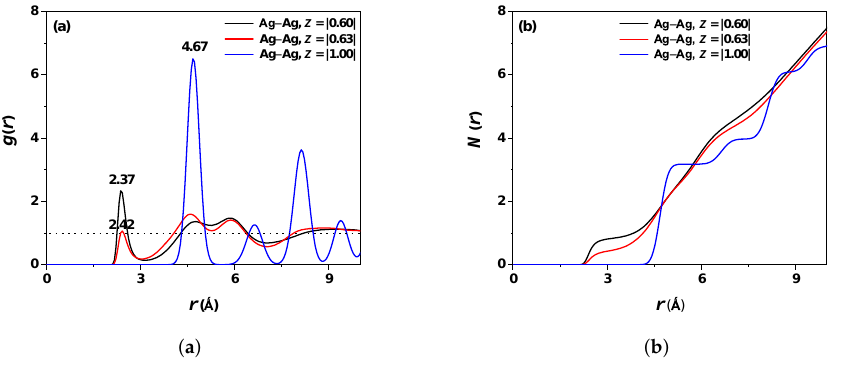
Figure 2. ( a ) PDF or g Ag-Ag ( r ) as a function of the distance r Ag-Ag , with Z Ag,Ag = | 0.60 | (black line), Z Ag,Ag = | 0.63 | (red line) and Z Ag,Ag = | 1.00 | (blue line). ( b ) Coordination number N Ag obtained by integrating PDF, at T = 300